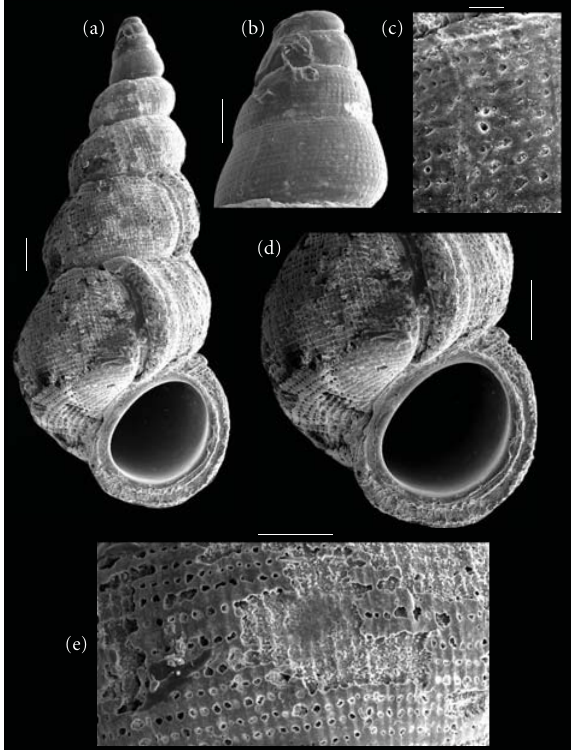
Figure 9: (a–e) Opalia revizee new species (holotype—MNRJ 18.307); (a) ventral view, (b) protoconch, (c) detail of protoconch ornamentation, (d) last whorl and aperture view, and (e) detail of teleoconch ornamentation. Scale bars: (a) 300 μ m, (b) and (e) 100 μ m, (c) 20 μ m, and (d) 200 μ